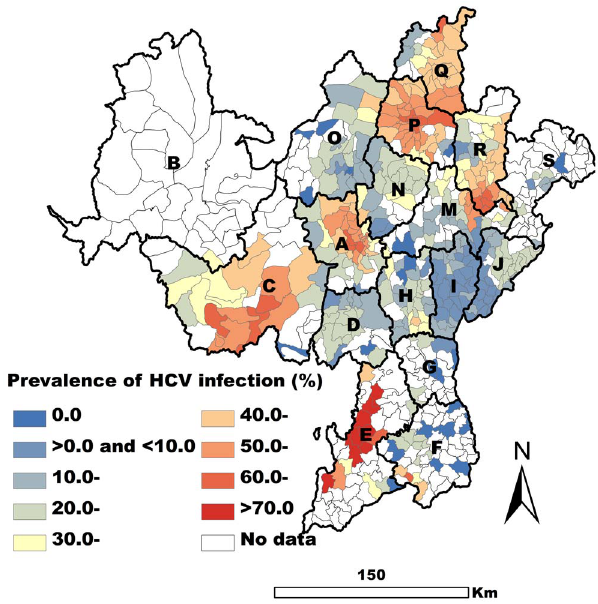
Figure 3. Spatial EB smoothed map of the prevalence of HCV infection by township.